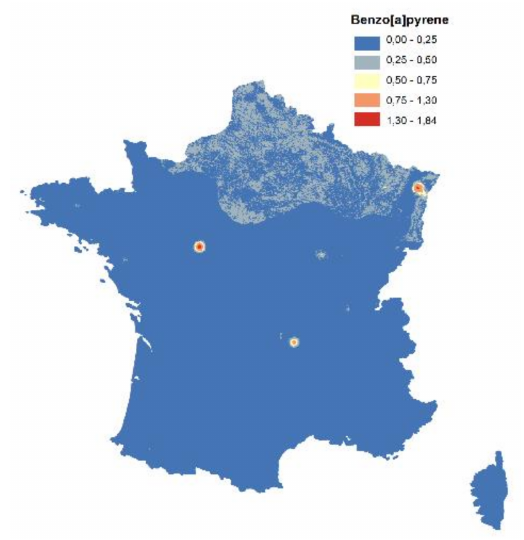
Figure 6. Spatialization of the B[a]P concentrations in soil (mg/kg).